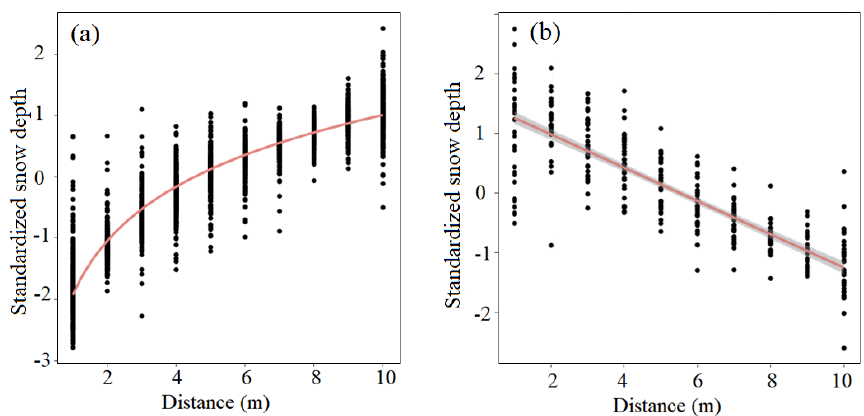
Figure 9. Increasing (a) and decreasing (b) snow depth trends and regression within a 10m distance from the tree edges for all sites together. The confidence interval depicted in this figure is 95%.